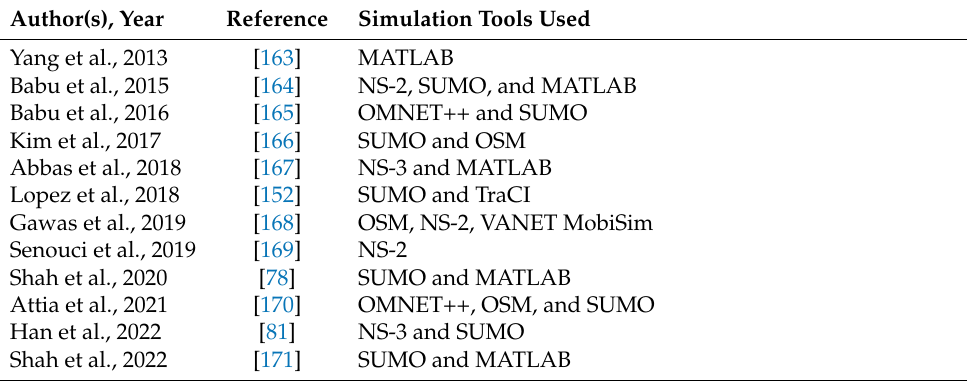
Table 3. List of research articles and simulation tools